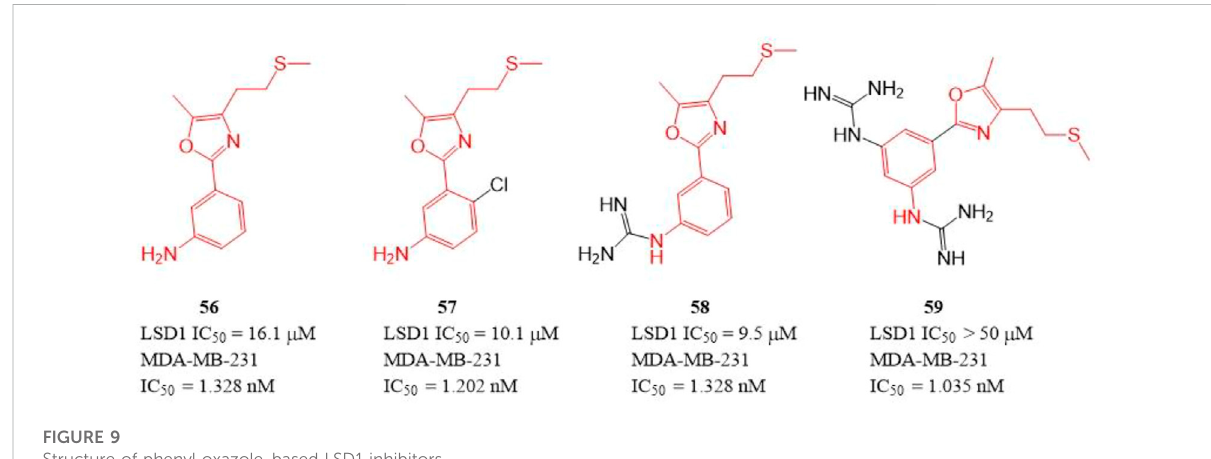
FIGURE 9 Structure of phenyl oxazole-based LSD1